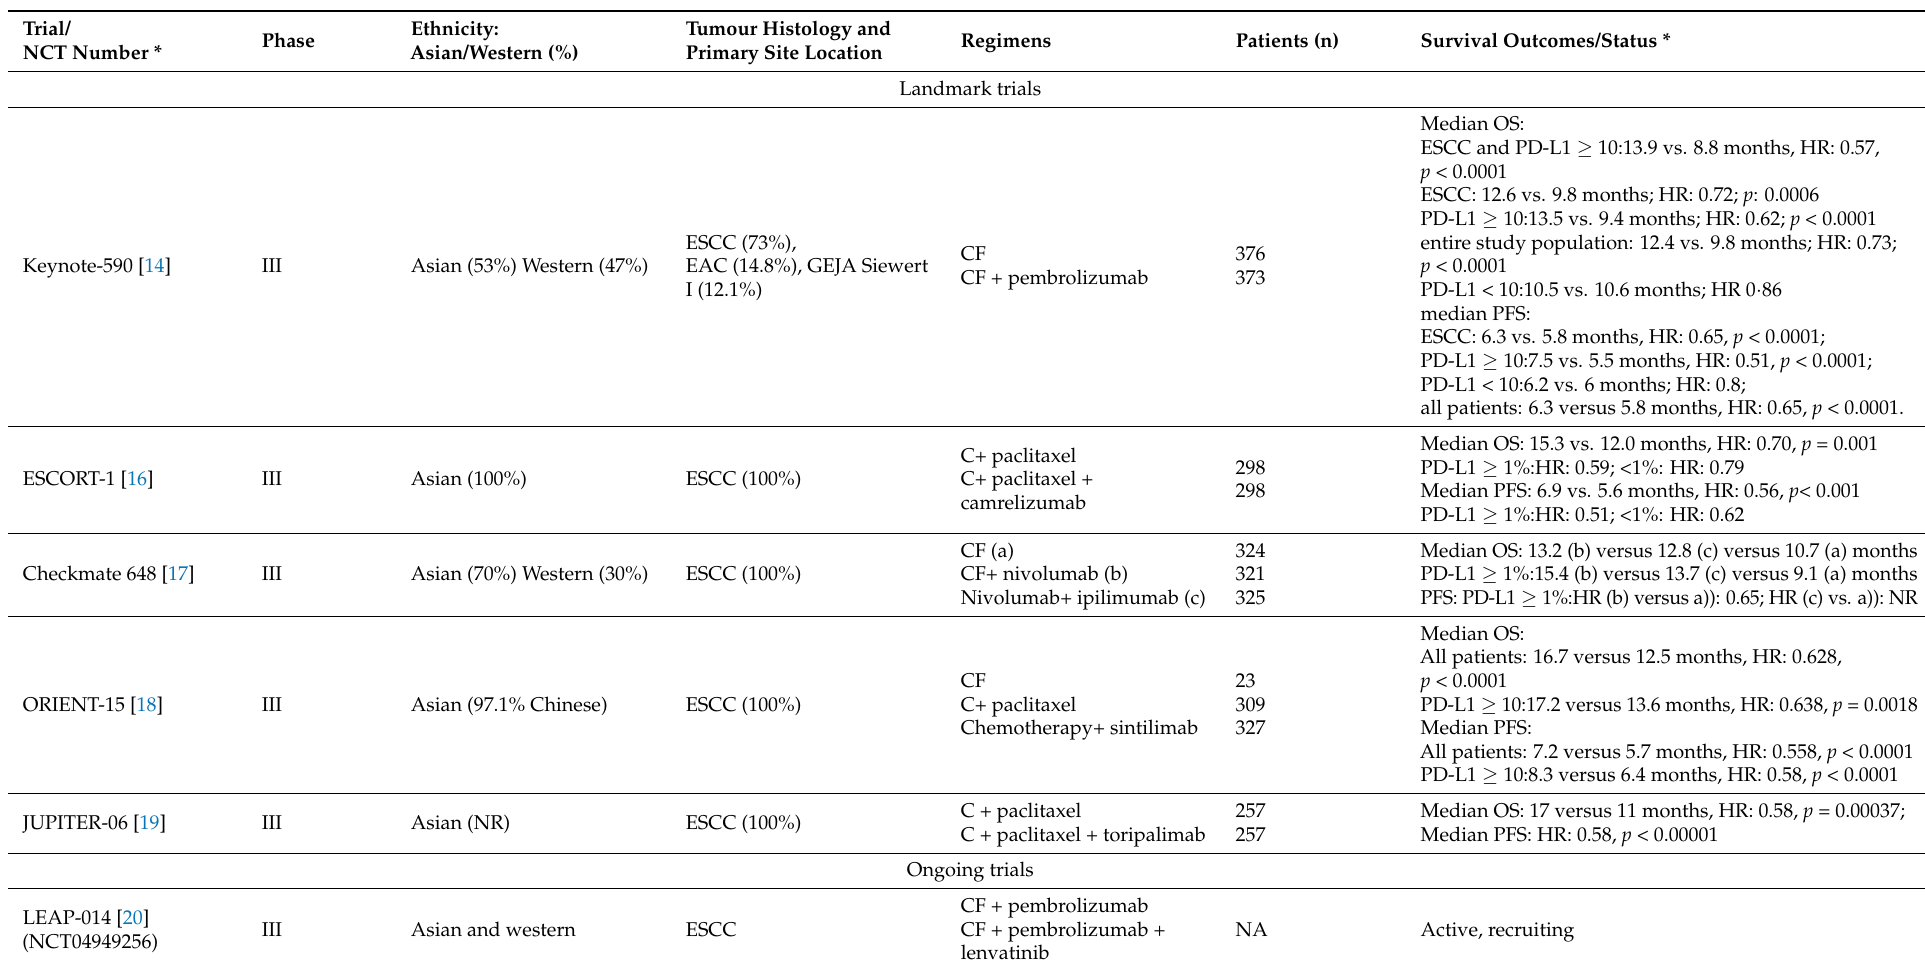
Table 1. Immune checkpoint inhibitors in the first-line setting for metastatic oesophageal squamous cell carcinoma: landmark phase III and main phase II/III ongoing